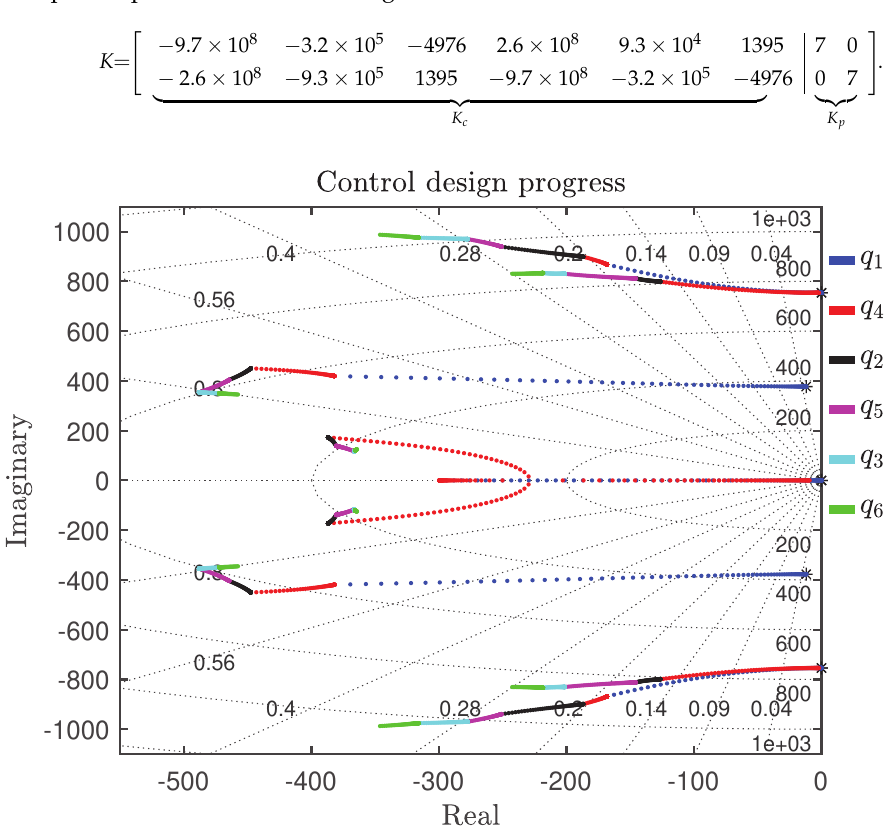
Figure 4. Loci of the closed-loop system poles for the L -type